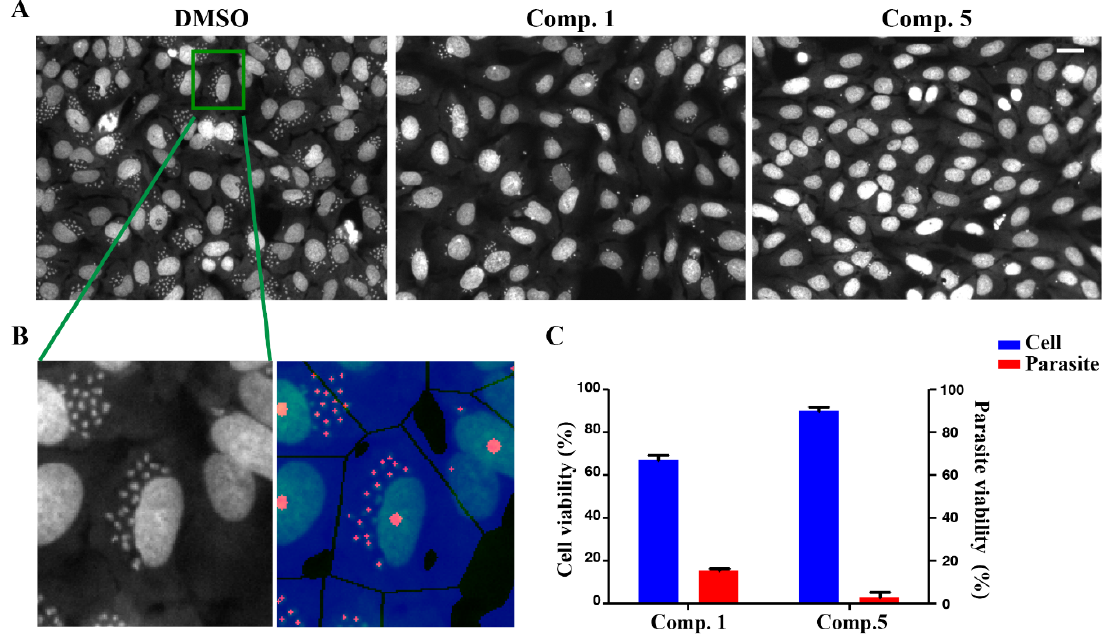
Figure 4. Assessment of the activity of laevigatol B ( 1 ) and 5 α -cholest-8(14)-ene-3 β ,7 α -diol ( 5 ) against intracellular amastigotes of T. cruzi by high content image assay coupled with quantitative image mining algorithm; ( A ) Images of intracellular T. cruzi with DMSO control (0.5%), compounds 1 and 5 at 50.0 μ M; ( B ) Image analysis of acquired image. Large red dots indicates U2OS nuclei, blue surface refers to cytosol of the corresponding host cell and small red dots refers to T. cruzi nuclei; ( C ) Quantified cell and parasite numbers from acquired images (4 fields) of control, compounds 1 and 5 treat wells. Scale bar, 40.0 μ